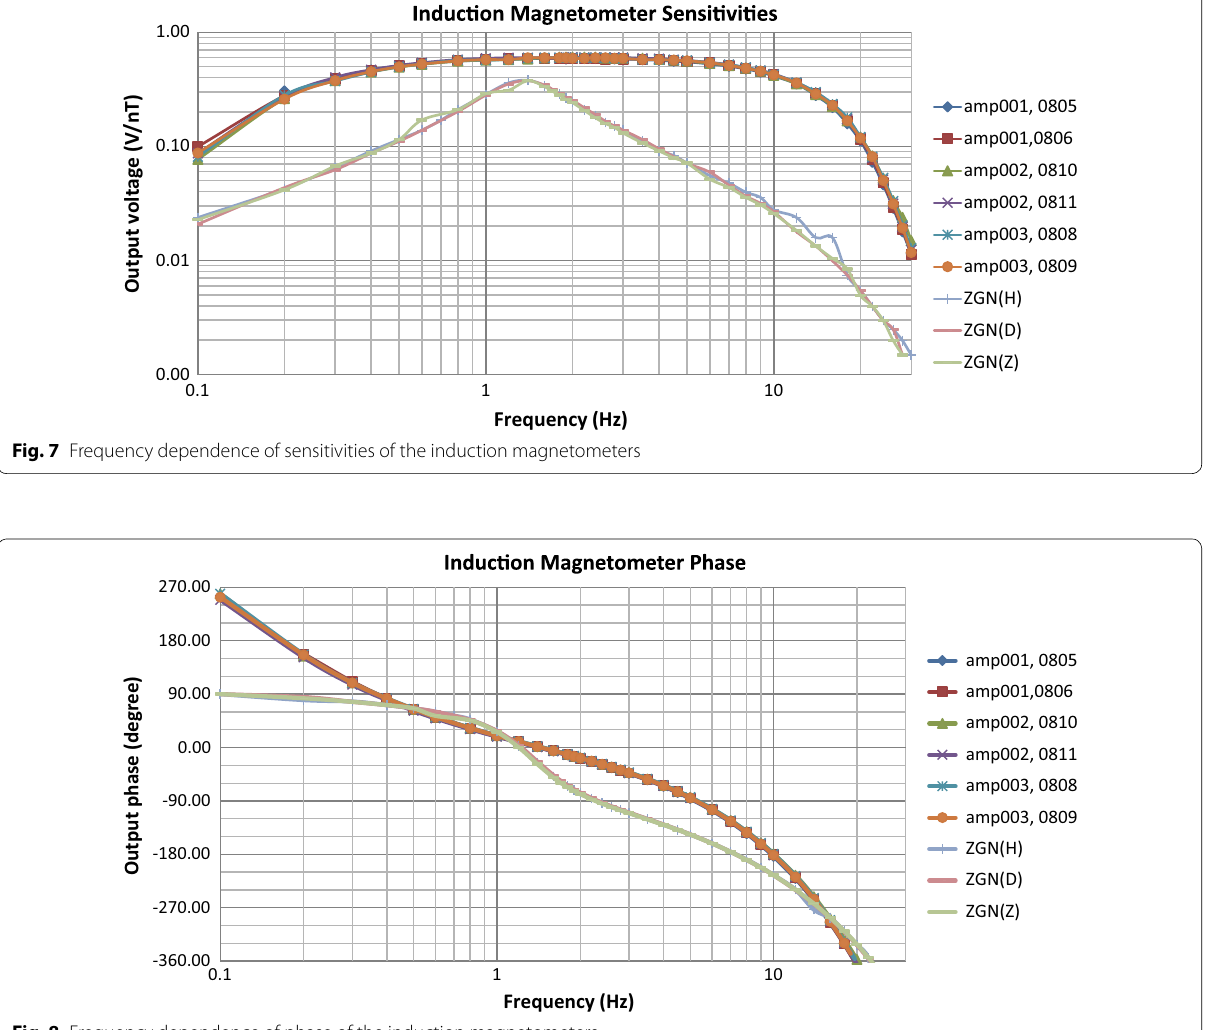
Fig. 8 Frequency dependence of phase of the induction